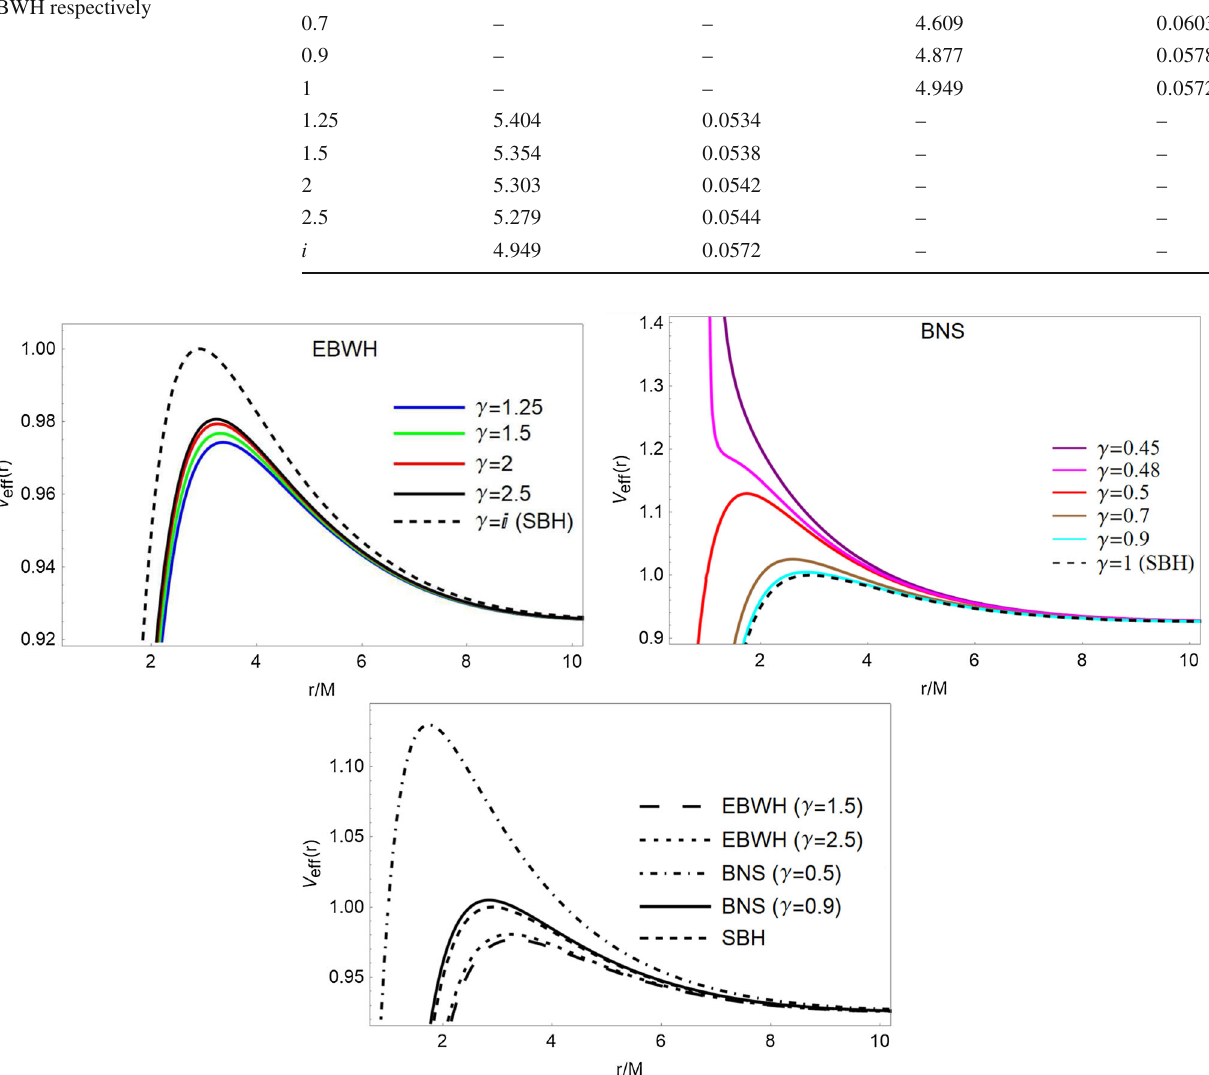
Fig. 2 The effective potential V eff for EBWH ( γ > 1), BNS ( γ < 1) and SBH ( γ = − i from EBWH, and γ = 1 from BNS) M , which in turn yields (cid:2) → 1 or 100% efficiency in 2 γ